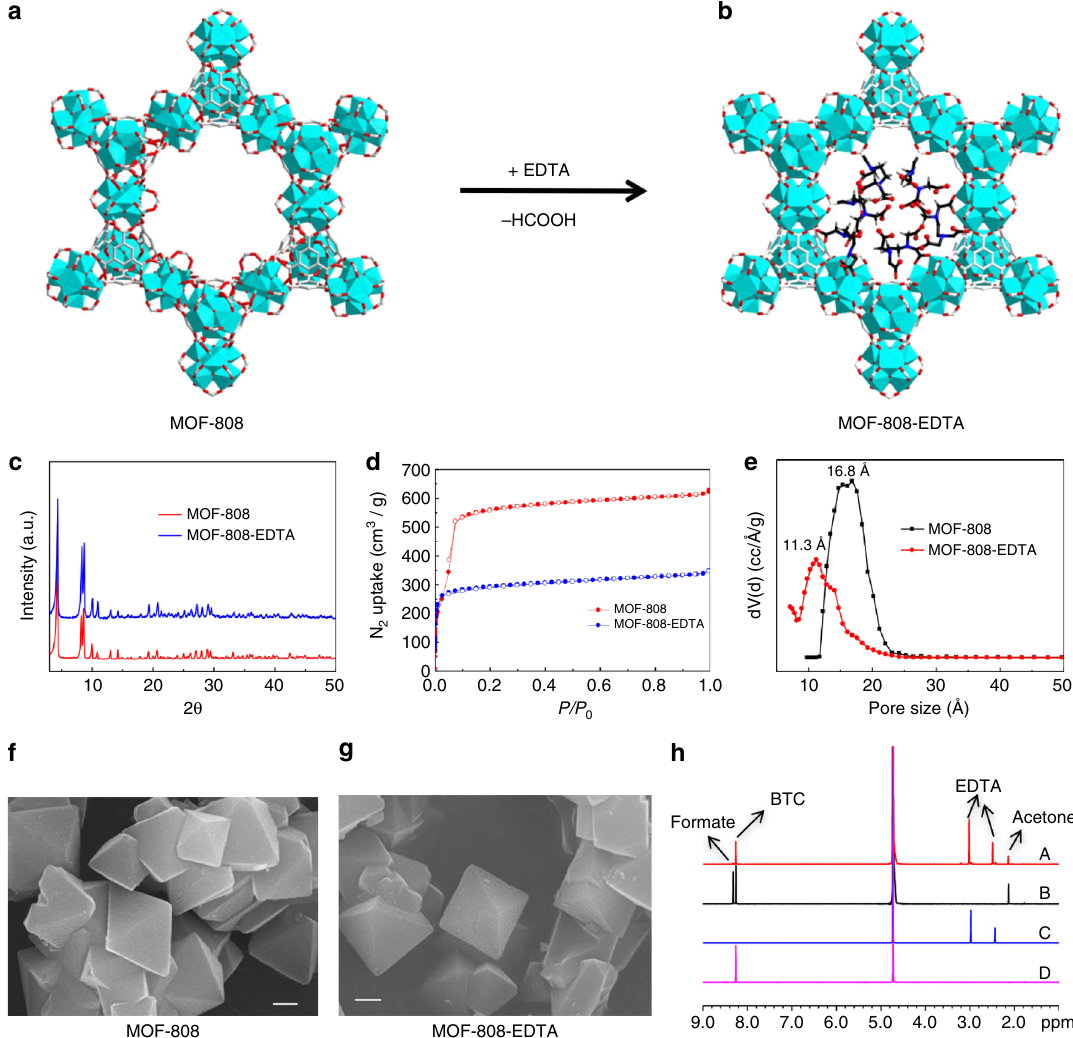
Fig. 2 Characterization and illustration of MOF-808 and MOF-808-EDTA. a , b Schematic illustration of the structures of the two MOFs. c PXRD patterns. d N 2 adsorption-desorption isotherms. e Pore size distributions. f , g SEM images (Scale bar, 500 nm). h 1 H NMR spectra of (A) alkaline-digested MOF-808- EDTA, (B) alkaline-digested MOF-808, (C) EDTA-2Na, and (D) H 3 BTC in KOH/D 2 O